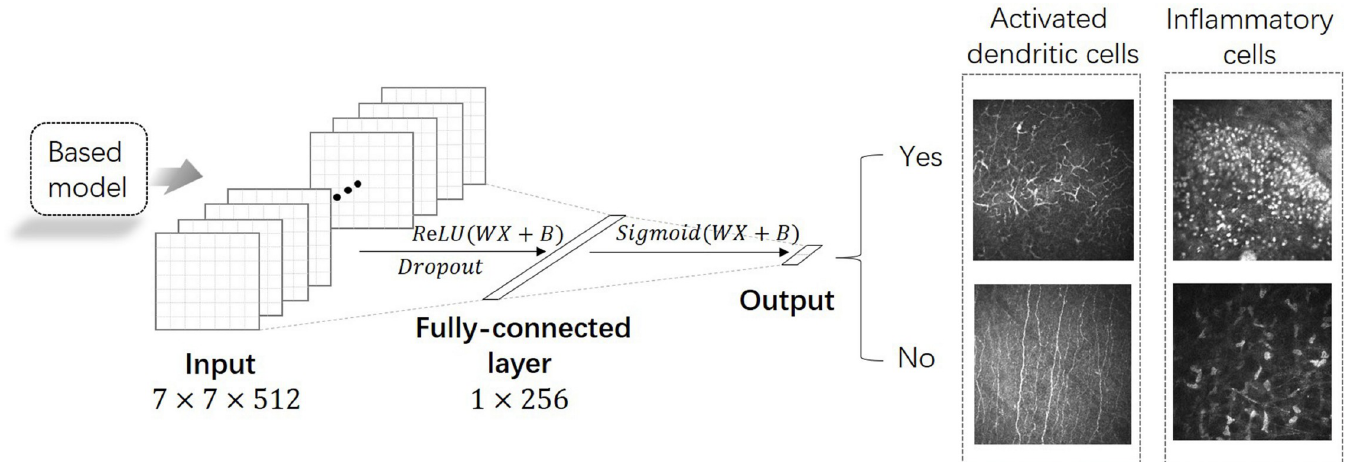
Fig 3. The adaptation layer of the deep transfer learning model. The front part of the pre-trained networks was adopted as the fixed feature extractor for our training dataset. We added an adaptation layer formed by two fully-connected layers that used the output vector of the fixed feature extractor as input. The activation function of the first fully-connected layer is ReLU, and the fully-connected output is a sigmoid